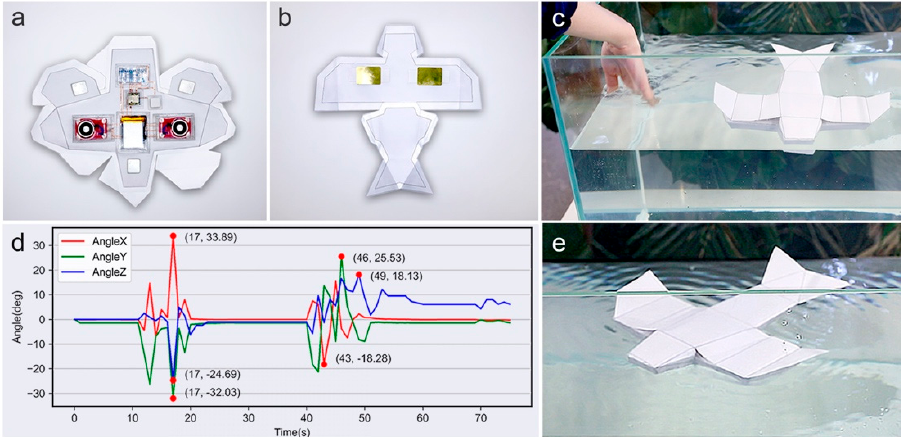
Figure 16. Fly Fish robot: ( a ) paper circuit of robot; ( b ) thin pieces of metal are stuck to the wings and can be attracted by electromagnets; ( c ) the user flaps the water to interact with the robot; ( d ) data captured by gyroscope; and, ( e ) the robot vibrates its wings to create ripples.